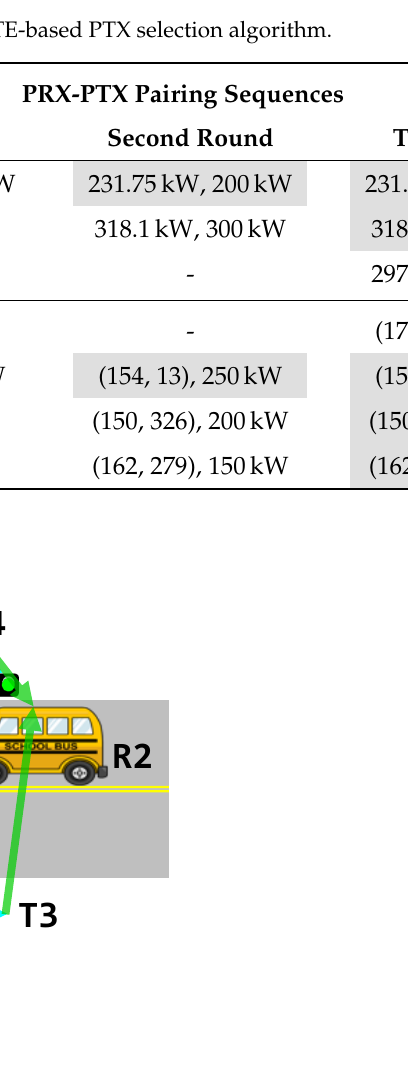
Figure 16. Results of power transmission path